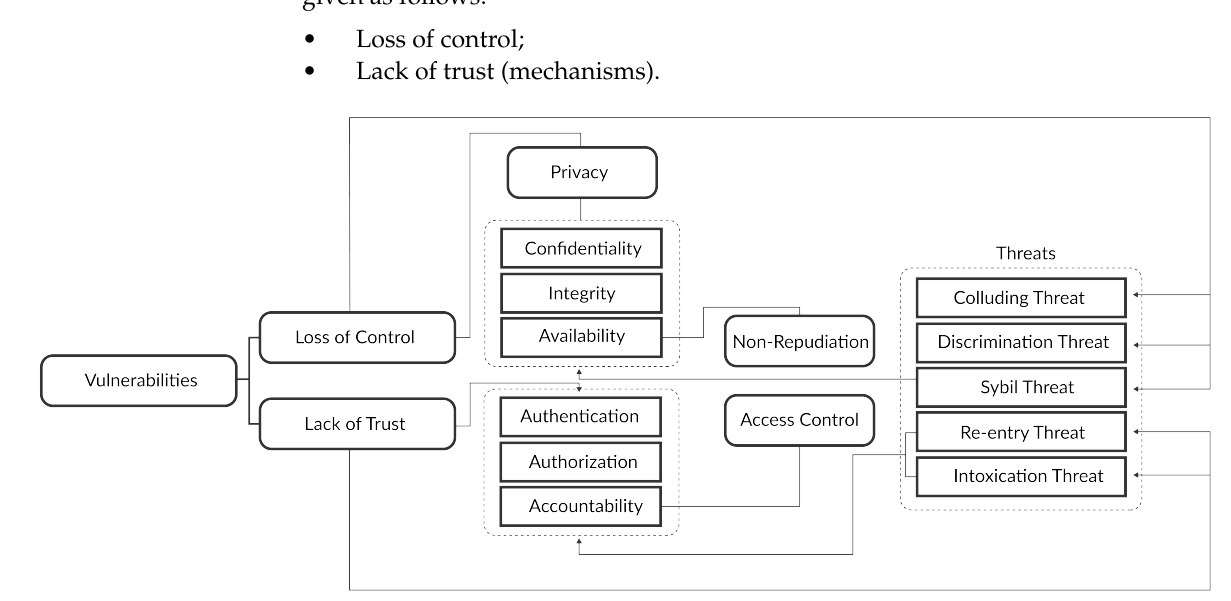
Figure 2. Security requirements, vulnerabilities, and